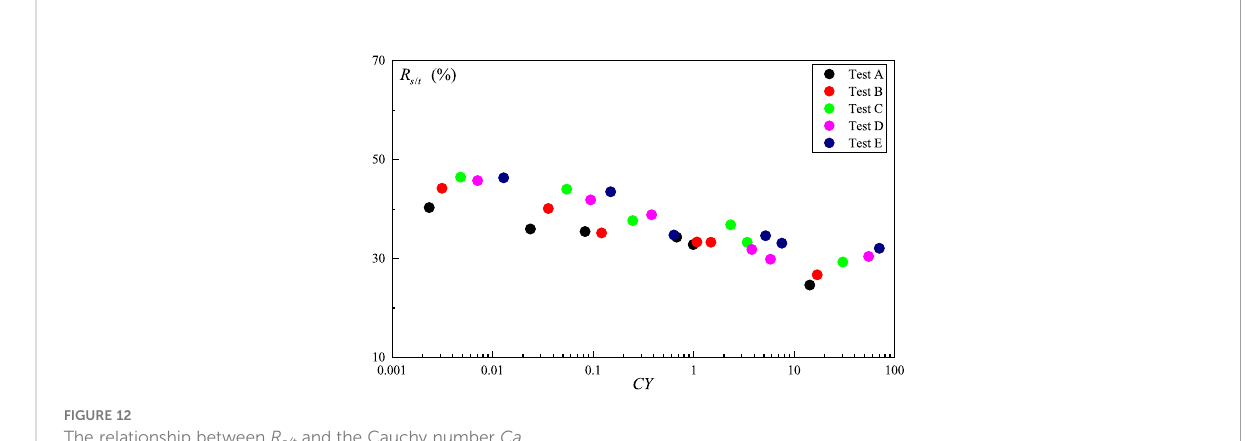
FIGURE 12 The relationship between R s/t and the Cauchy number Ca .